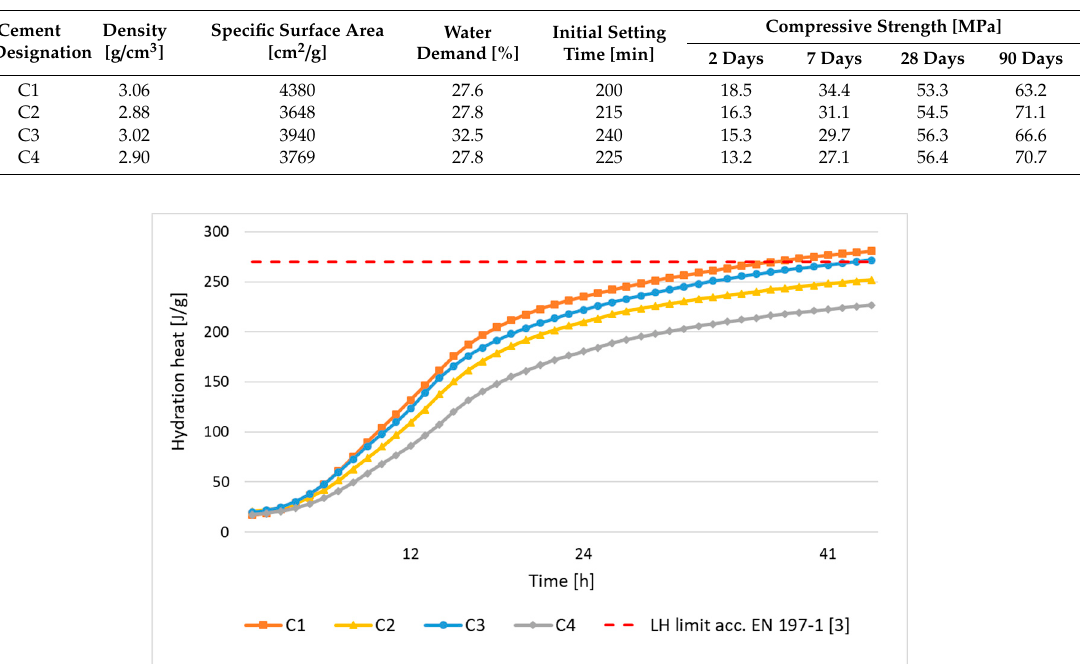
Figure 1. Heat released during low-emission cement hydration process. (Semi-adiabatic method consistent with EN-196-9 [20]).